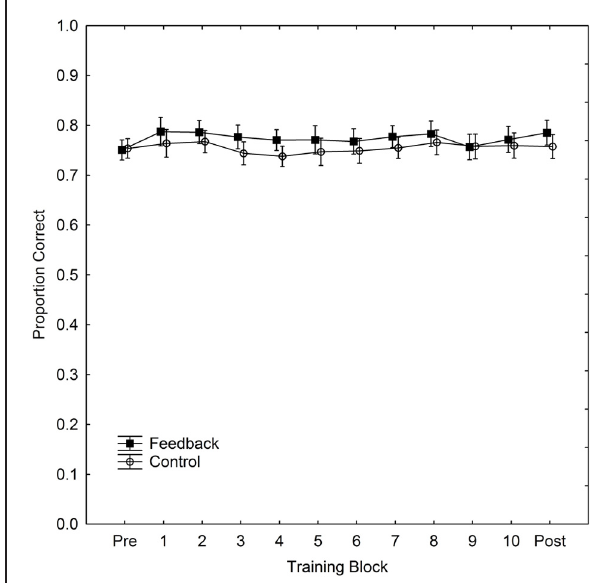
FIGURE 1 | Performance (proportion correct) in the ANS acuity task as a function of training block and condition during 1000 trials of training. The figure also includes performance in pre- and post-tests. Vertical bars denote 95% confidence